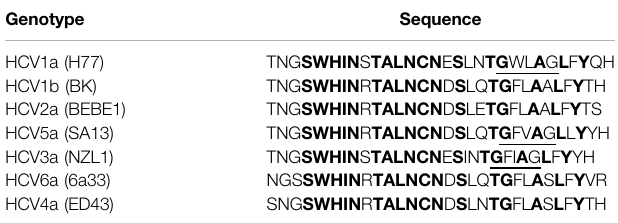
TABLE8| Alignmentofsegment416 – 445fromvariousgenotypesofHCV.Inbold arerepresentedthehighlyconservedresidues.Ingreen,aminoacidsmodi fi ed by mutagenesis. Underlined, the GxxxG motif. In red, glycosylation sites.